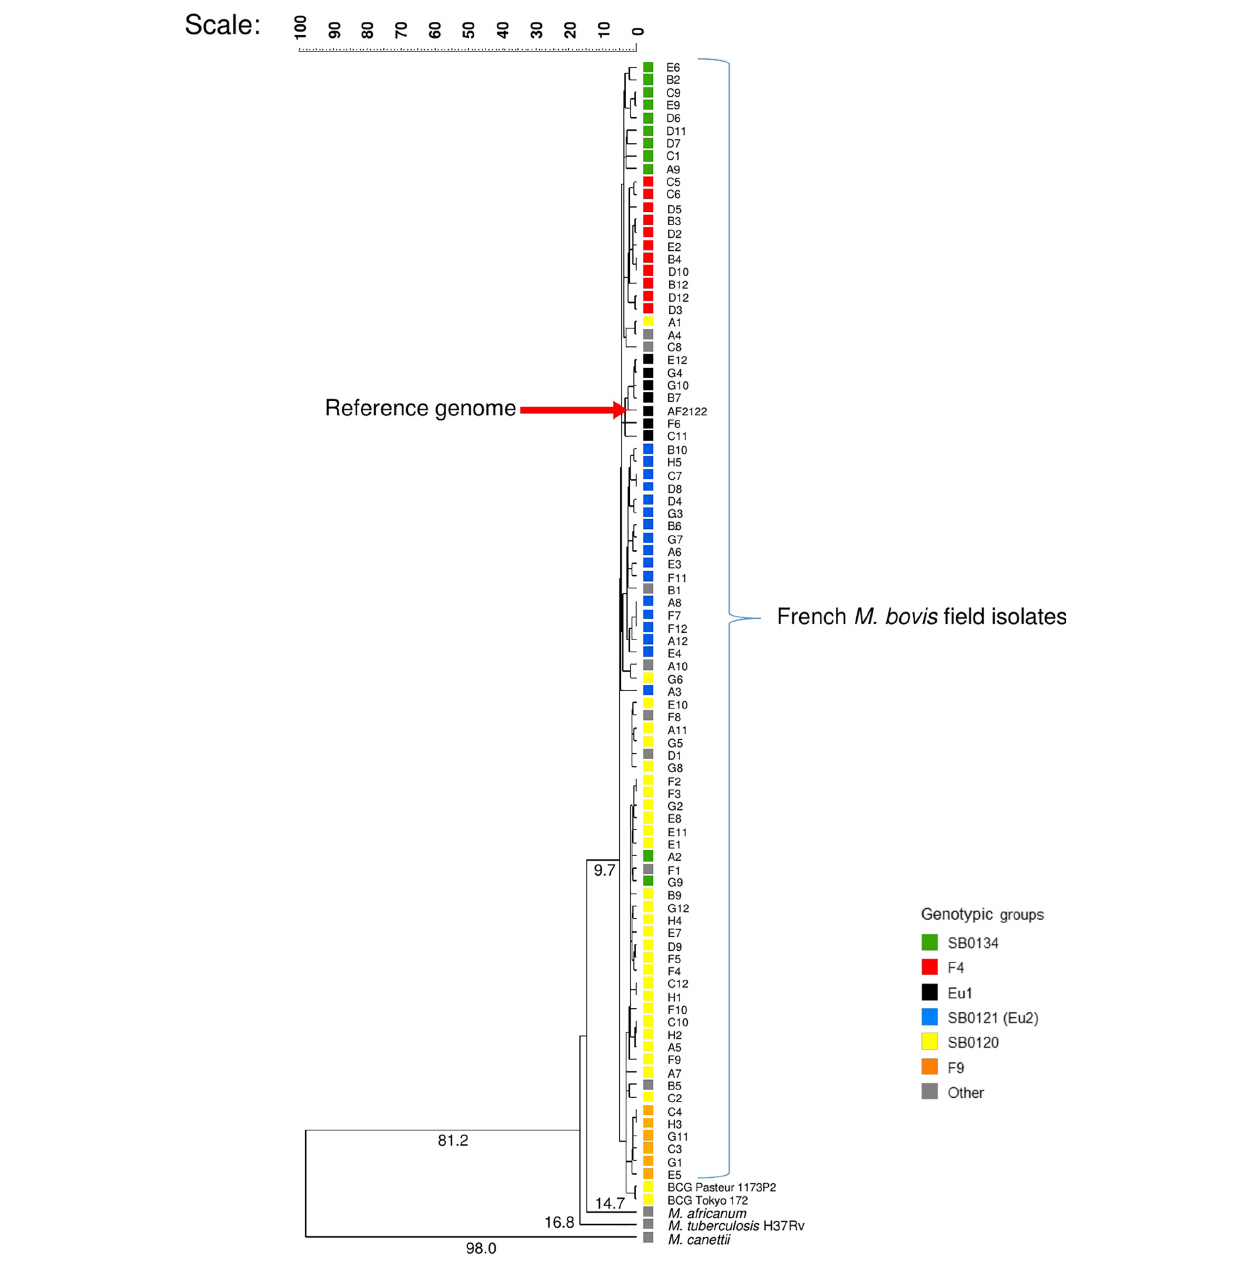
FIGURE 1 | Whole genome-based evolutionary analysis of the panel of French field isolates of M ycobacterium bovis . The phylogenetic tree with numbered above the branches indicating the similarity coefficient between the organism and its common ancestor was constructed with whole genome, using the software bionumerics vs. 7.6.2 with the settings: similarity coefficient by categorical, scaling factor of 100 and clustering method by